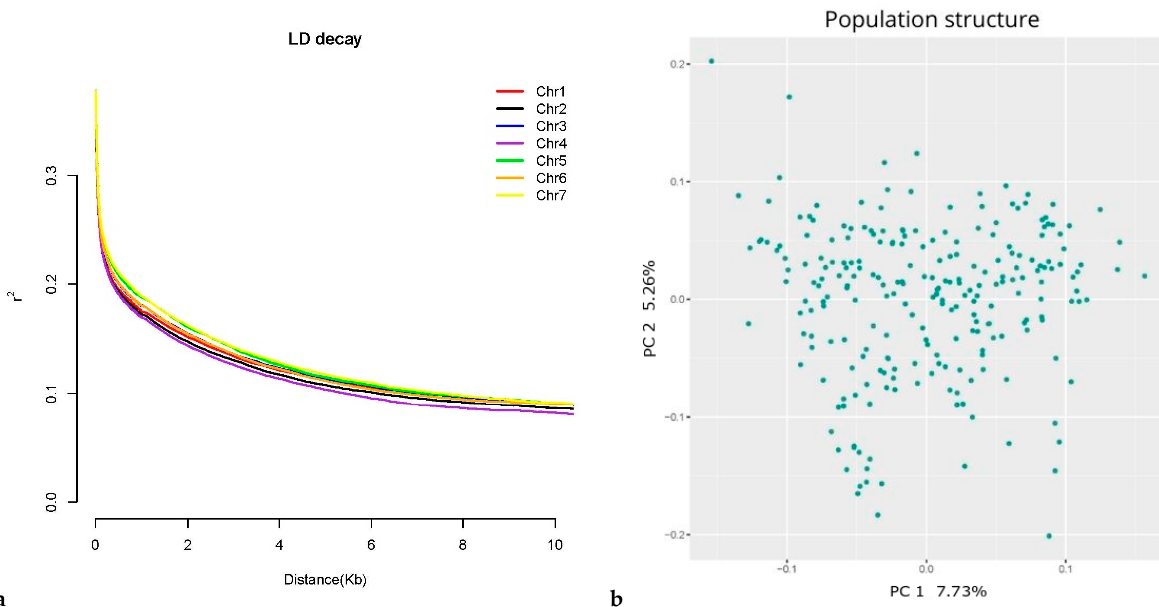
Figure 2. Genome-wide LD decay in the core collection population ( a ). LD decay is measured as a function of the distance between SNPs for each chromosome. The colour code is described in Figure Figure 2a. Principal Component Analysis of population structure ( b ). The x- and y -axis refer to the first two principal